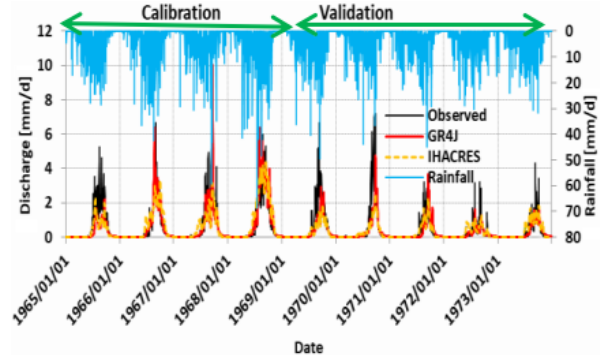
Figure 2. Models observed and simulated discharge between 1965 and 1973.